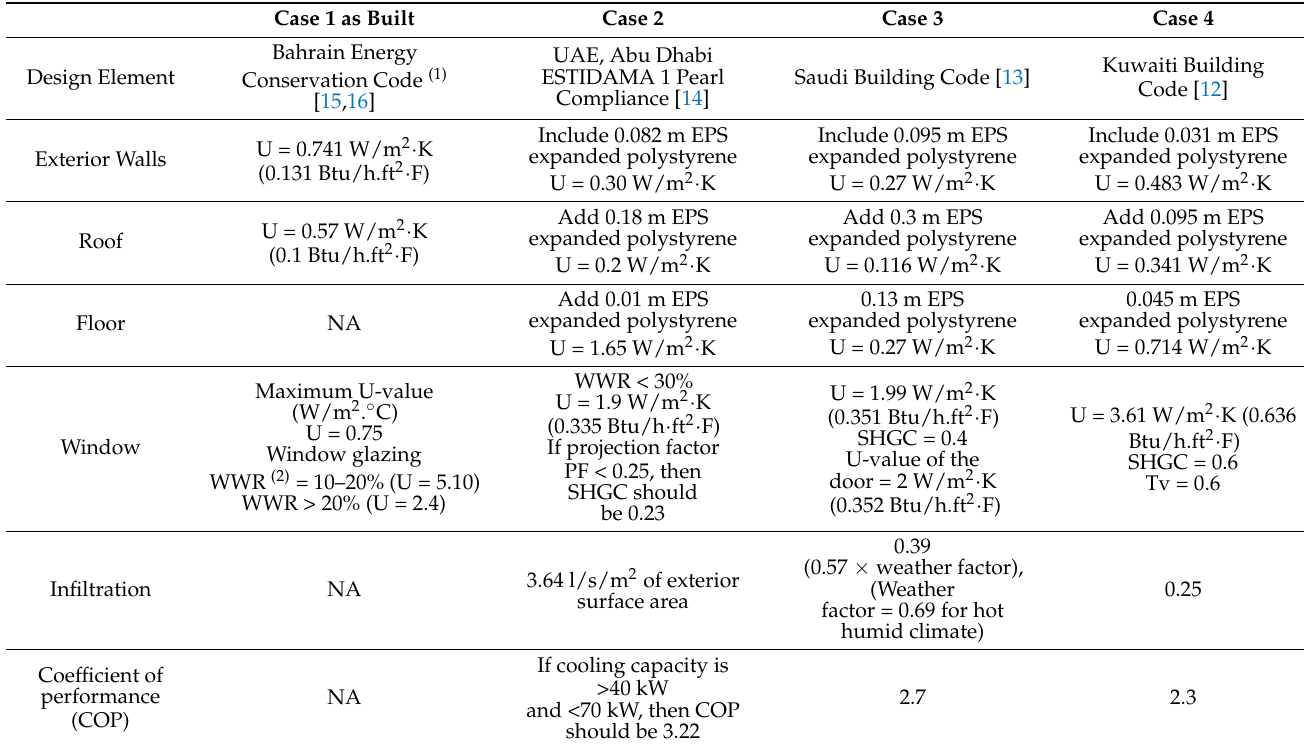
Table 6. The examined case studies, including the proposed changes as per the GCC energy conservation codes.